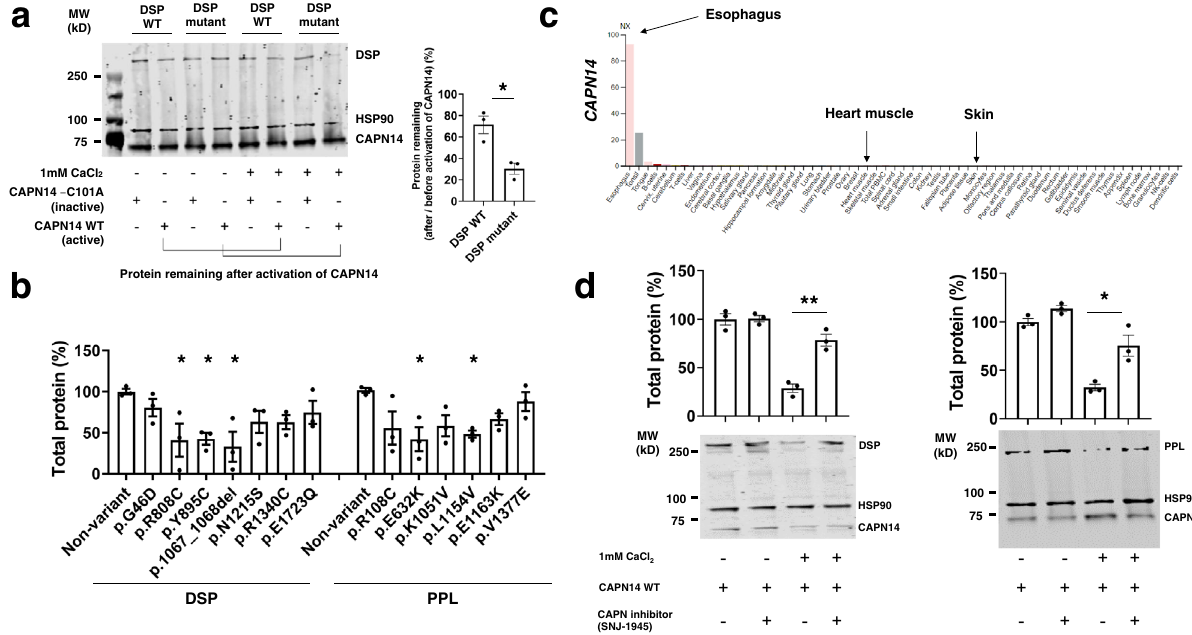
Fig. 5 Calpain 14 – mediated desmosomal protein degradation. a Immunoblots of lysates from DSP (non-variant or mutant p.Y895C) – transfected HEK293T cells with CAPN14 or enzymatically inactive CAPN14-C101A co-transfection for changes in DSP levels following the addition of exogenous Ca 2 + (left). Protein remaining after activation of CAPN14 was determined by the difference in band intensity between after and before activation [(after x 100)/ before] (right). Statistics: DSP WT vs. DSP mutant, P = 0.0131. b Effect of DSP and PPL variants on protein degradation on activation of co-transfected CAPN14. Total protein remaining was determined for each mutation. Total protein (%) = (each protein remaining x 100)/average of non-variant cells. Statistics (versus non-variants): p.G46D, P = 0.8212; p.R808C, P = 0.0296; p.Y895C, P = 0.0352; p.1067_1068del, P = 0.0125; p.N1215S, P = 0.2675; p.R1340C, P = 0.2581; p.E1723Q, P = 0.6186; p.R108C, P = 0.0712; p.E632K, P = 0.0156; p.K1051V, P = 0.0946; p.L1154V, P = 0.0323; p.E1163K, P = 0.2167; p.V1377E, P = 0.9157. c Gene expression of CAPN14 in human normal tissues from the Human Protein Atlas